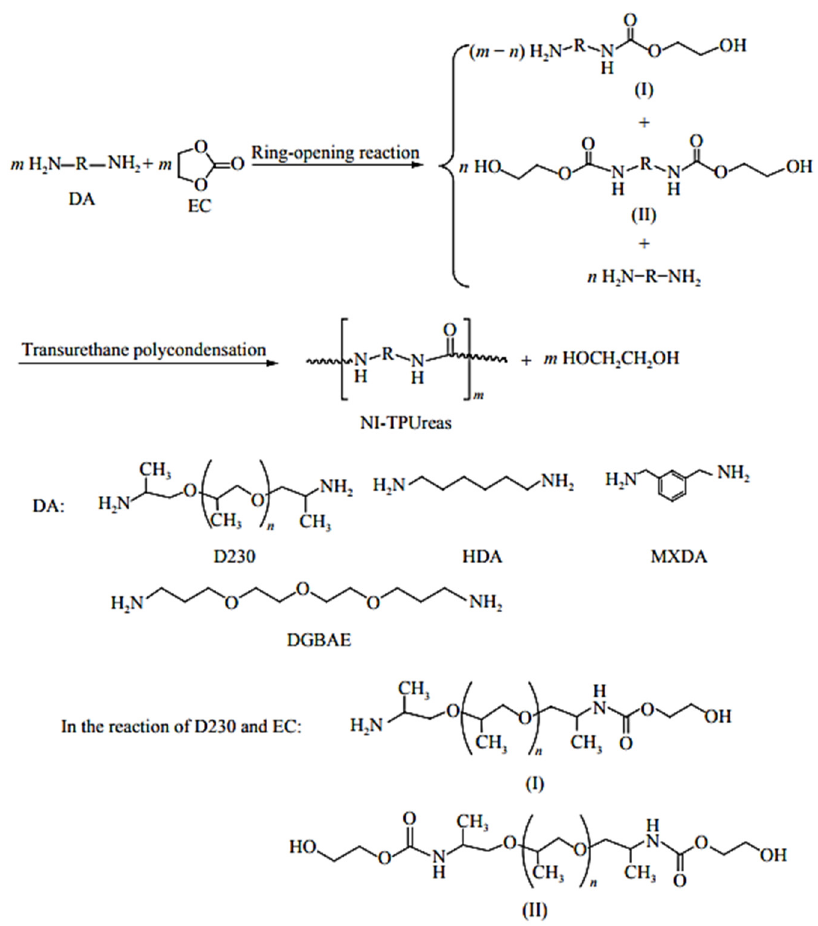
Figure 53. Synthesis of NI-TPUreas from Das and EC. From reference [80].